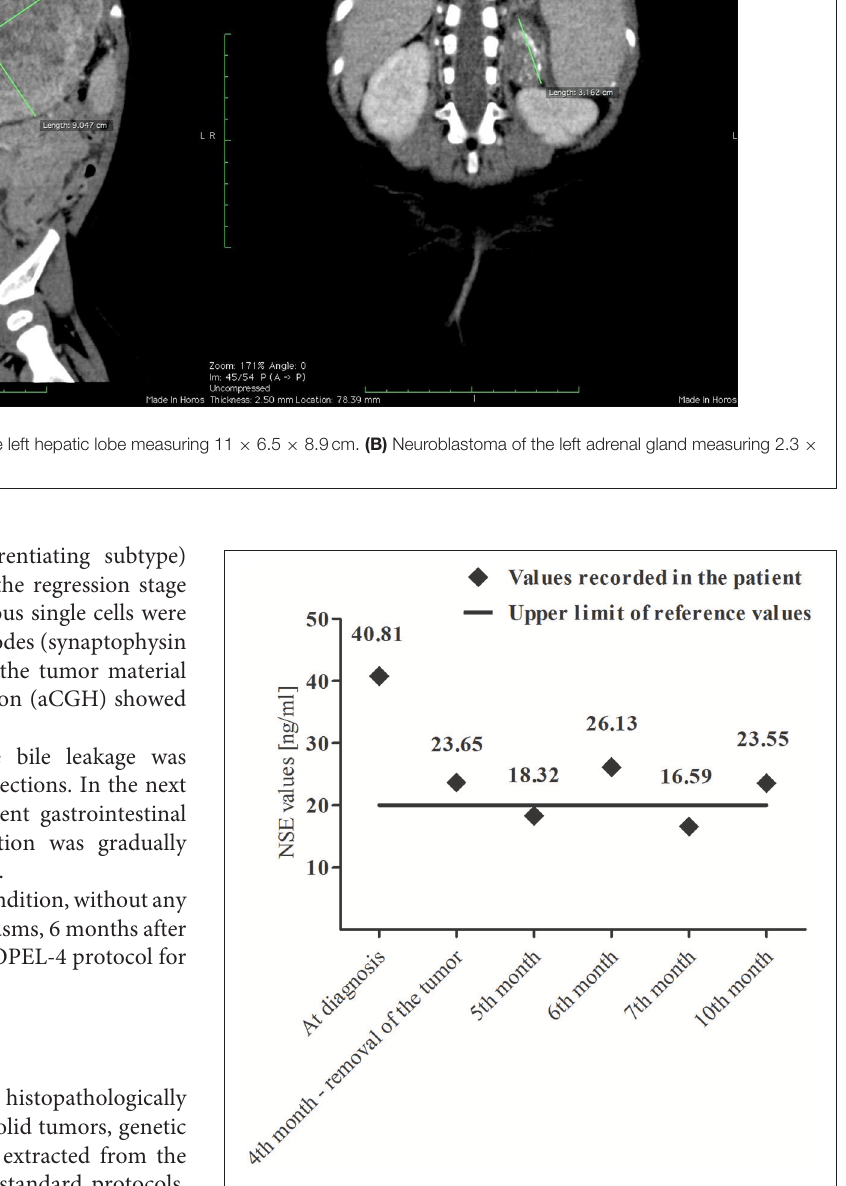
The personalized panel of genes was created based on Human Phenotype Ontology (HPO) (version: April 13,